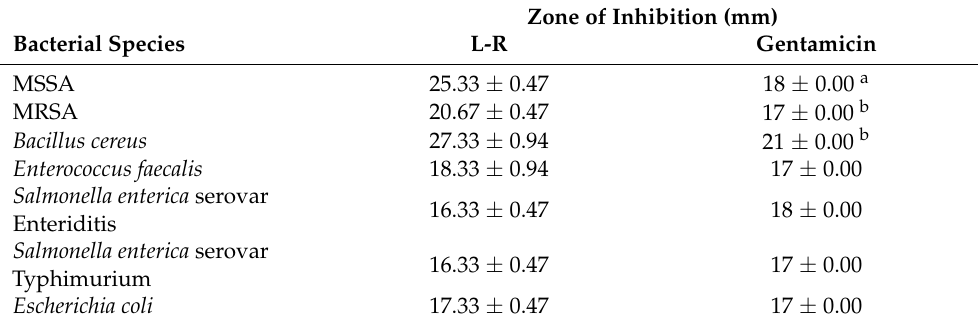
Zone of Inhibition (mm)